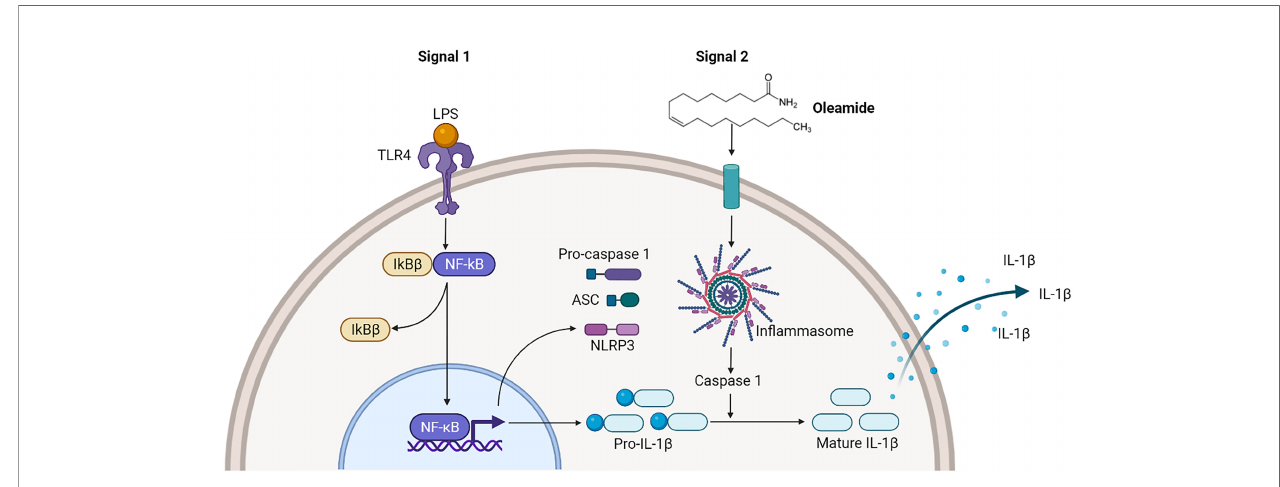
FIGURE 6 | Oleamide activation of NLRP3 in fl ammasome of M1 phenotypes. The priming step (signal 1) by LPS involved an NF- k B-dependent upregulation of cellular NLRP3 and pro-IL-1 b , while the second step (signal 2) was induced by oleamide activating in fl ammasome and cleaving IL-1 b . The released IL-1 b may help to induce the polarization of naive macrophages (M0) into M1 phenotypes by supporting